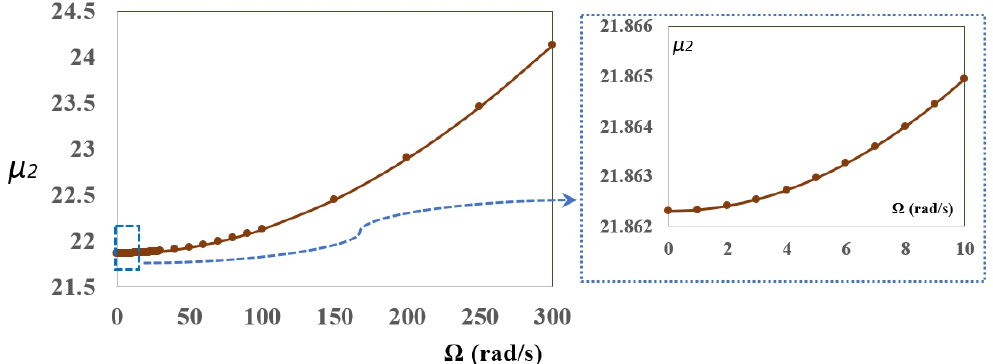
Figure 4. Dimensionless natural frequency, µ 2 , vs. rotational speed Ω for: r = 0.26, ξ c = 0.35, α = 0.22 and S L =